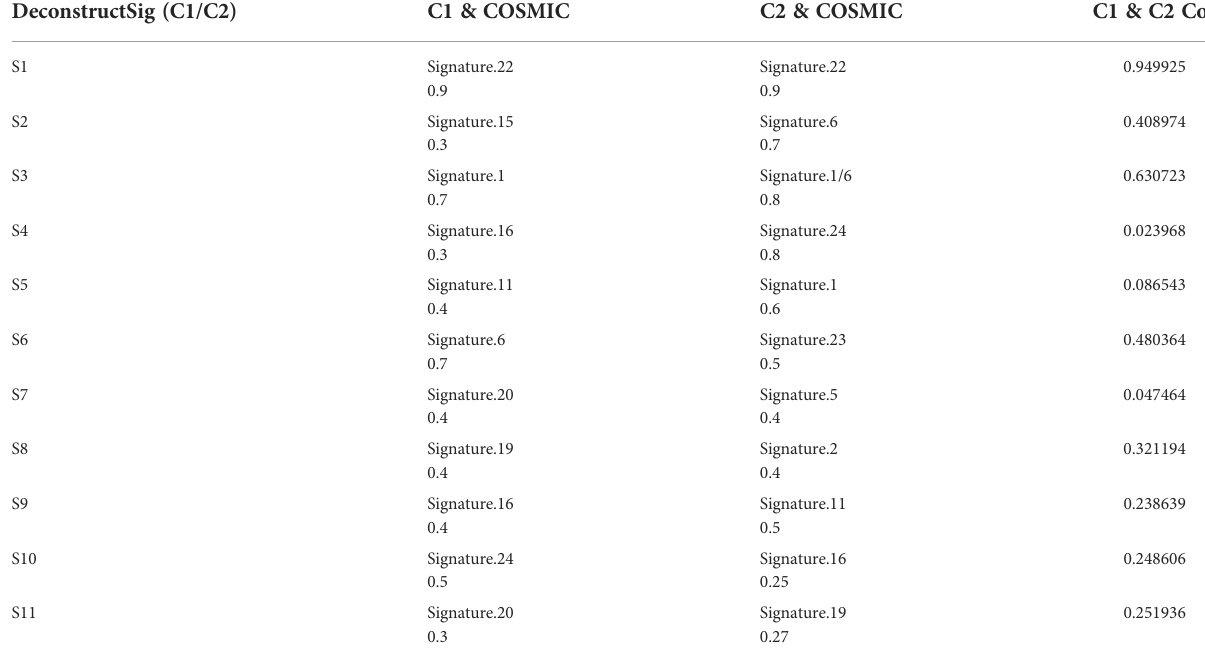
TABLE 1 Correlation between denovo somatic signatures and cosmic database. DeconstructSig